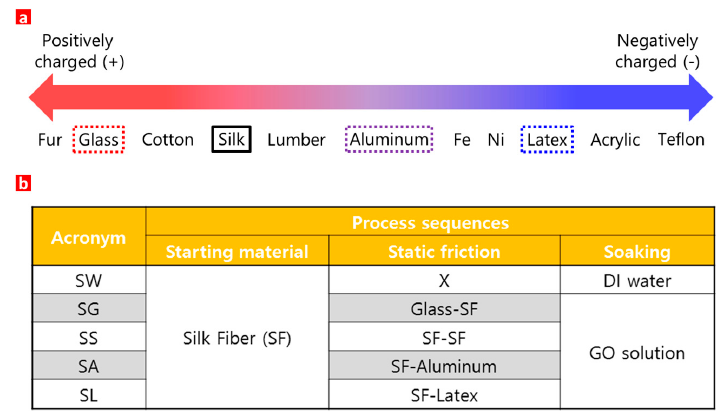
Figure 1. ( a ) Relative tendency of electrons to move from the SF when it contacts and separates from other materials [28]; ( b ) Various GO-coated SFs at various conditions.